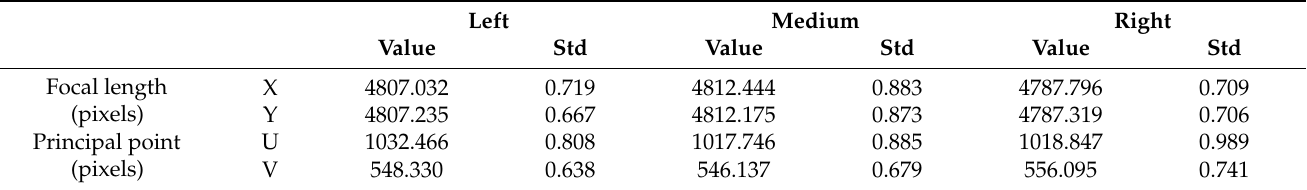
Table 1. Camera calibration parameters and related errors. Std represents the uncertainty of the optimized results.